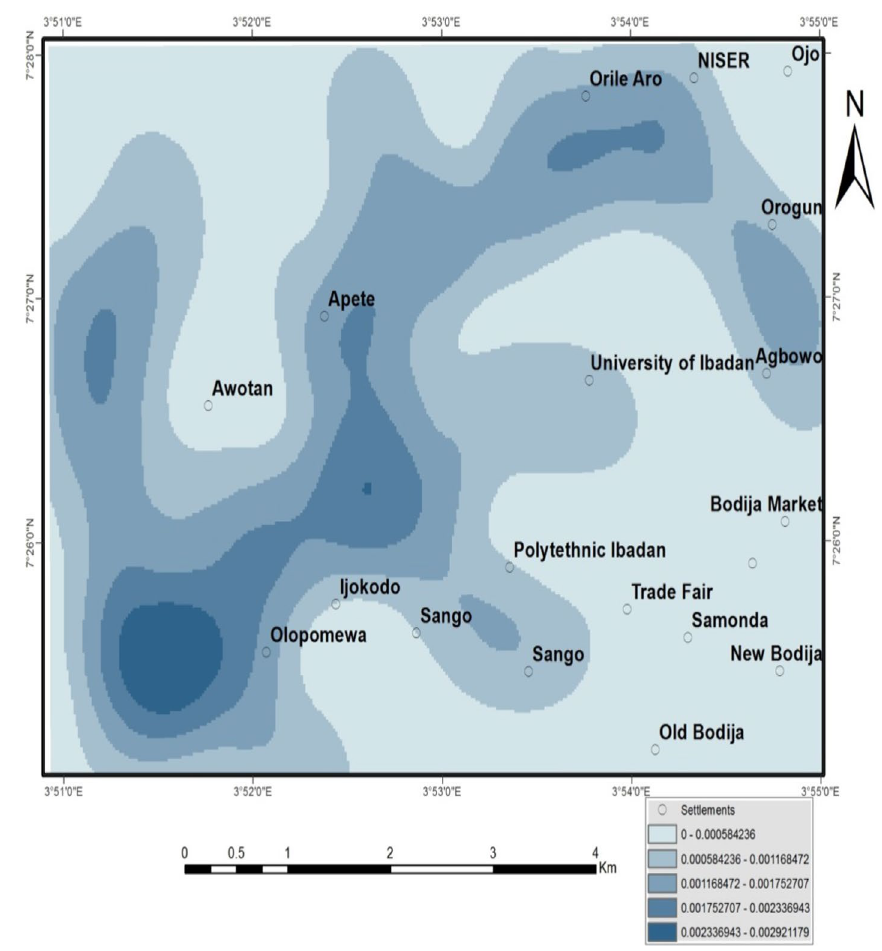
Fig. 7 Drainage density map of the study area